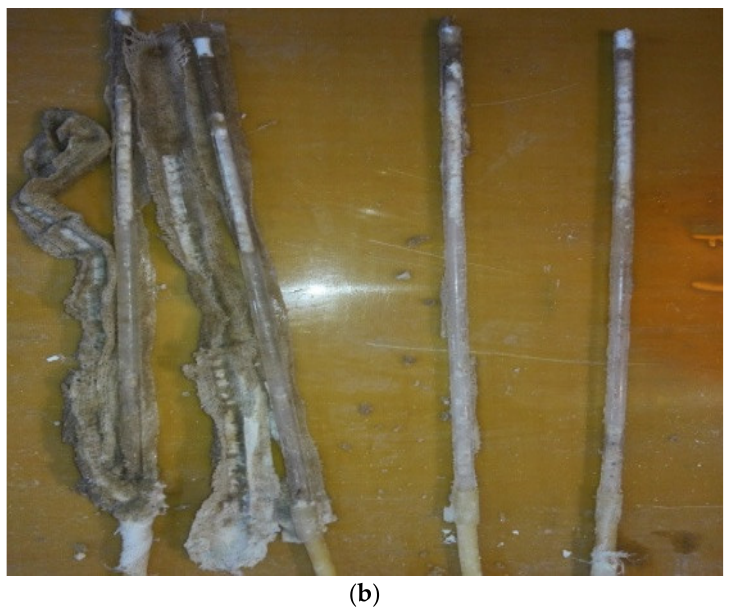
Figure 7. Heterogeneity of calcium carbonate deposition in the sand in the horizontal plane. ( a ) Obvious calcium carbonate deposition near the bored pipe. ( b ) Calcium carbonate blockage at the injection port of the bored pipe.